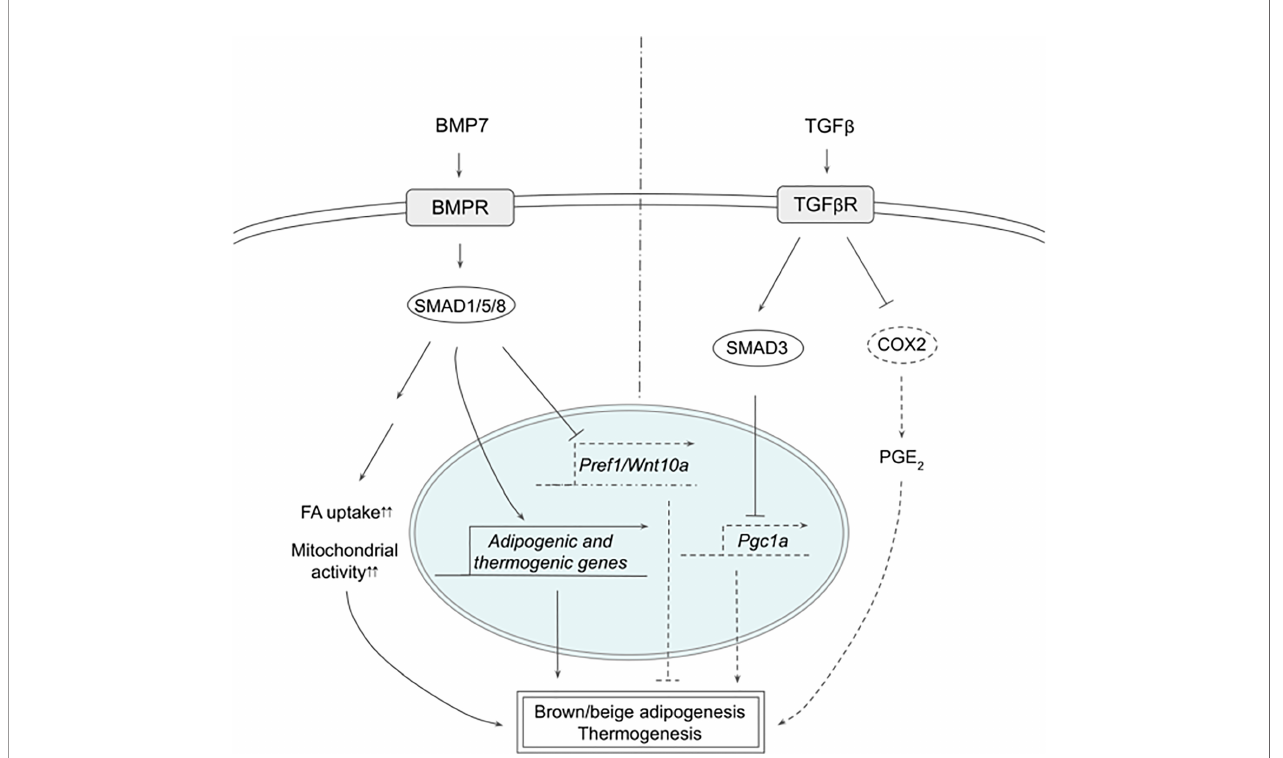
FIGURE 2 | Schematic models of BMP7 and TGF b signaling pathways in thermogenesis. BMP7 binds TGF b R, which activates SMAD1/5/8, leading to expression of adipogenic and thermogenic genes as well as suppression of Pref1 and Wnt10a in precursor cells to promote brown and beige adipogenesis. In mature adipocytes, BMP7 signaling increases FA uptake and mitochondrial activity, resulting in enhanced thermogenesis. TGF b activates SMAD2/3 that suppresses PGC1 a expression and COX2/PGE2 pathway to reduce thermogenesis. See text for details. BMP7, bone morphogenetic protein 7; COX2, cyclooxygenase 2; FA, fatty acid; PGC1 a , peroxisome proliferator activated receptor g ; PGE2, prostaglandin E2; PREF1, preadipocyte factor 1; SMAD, mothers against decapentaplegic homolog; T b R1, TGF b receptor 1; TGF b , Transforming growth factor beta; TGF b R, TGF b receptor; WNT10a, Wnt family member